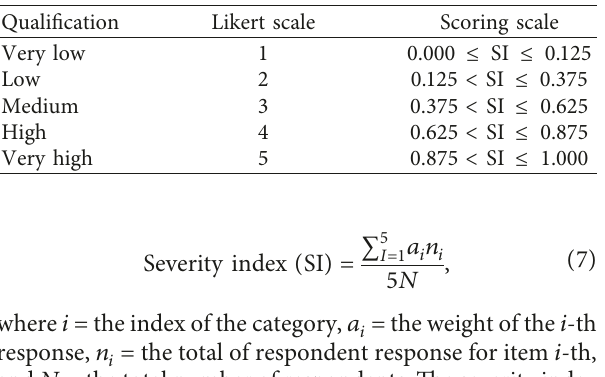
Table 3: Criteria and rating scale SI